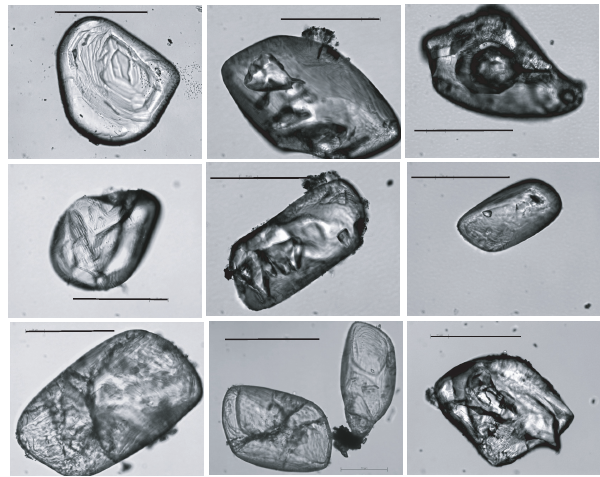
Fig. 3. Examples of ikaite crystals found in the sea ice. Scale bar is